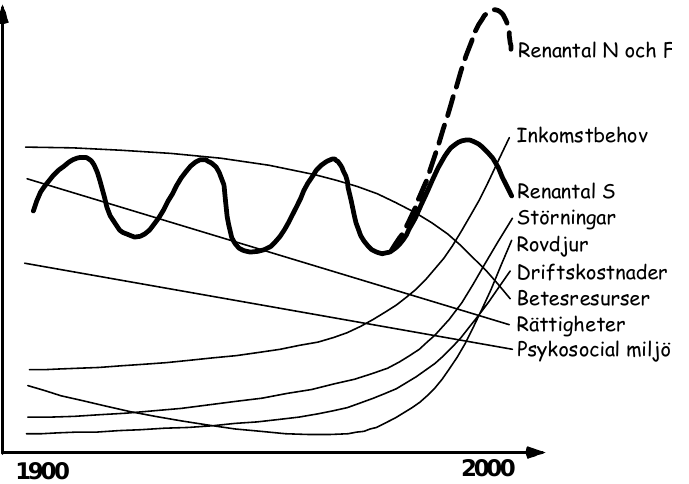
Schematisk beskrivning av förändringar i renantal i Sverige (S) resp. Norge (N) och Finland (F) samt förutsättningar för rennäring under de senaste hundra åren, i huvudsak baserat på förhållanden i Sverige. Trenderna är uttryckta i godtyckliga skalor och nivåer.